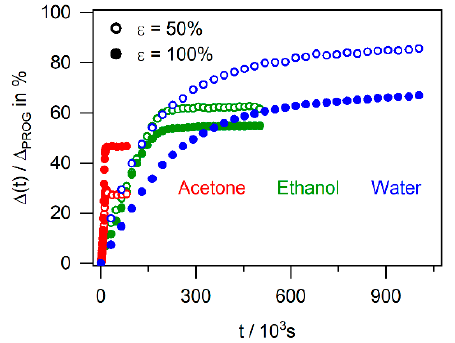
Figure 13. Direct comparison of chemical actuation kinetics of SMP-E. Evolution of ( ∆ ( t )/ ∆ PROG ) × 100 in % with time in s for unconstrained recovery triggered by acetone, ethanol, and water. For details, see text.